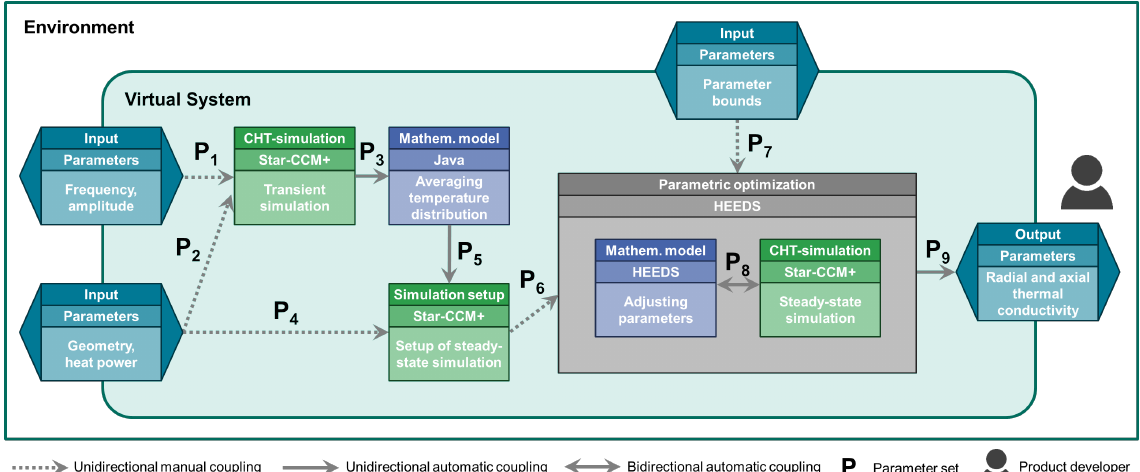
Figure 1. Graphical illustration of the proposed approach adapted from